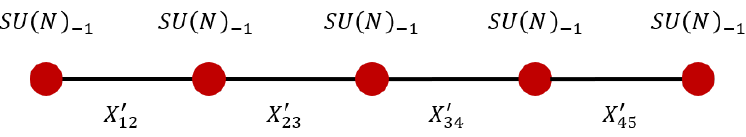
Figure 2. Quiver gauge theory for the special case of n = 5 nodes. As usual, nodes denote gauge groups and links denote bifundamental Wilson-Fisher